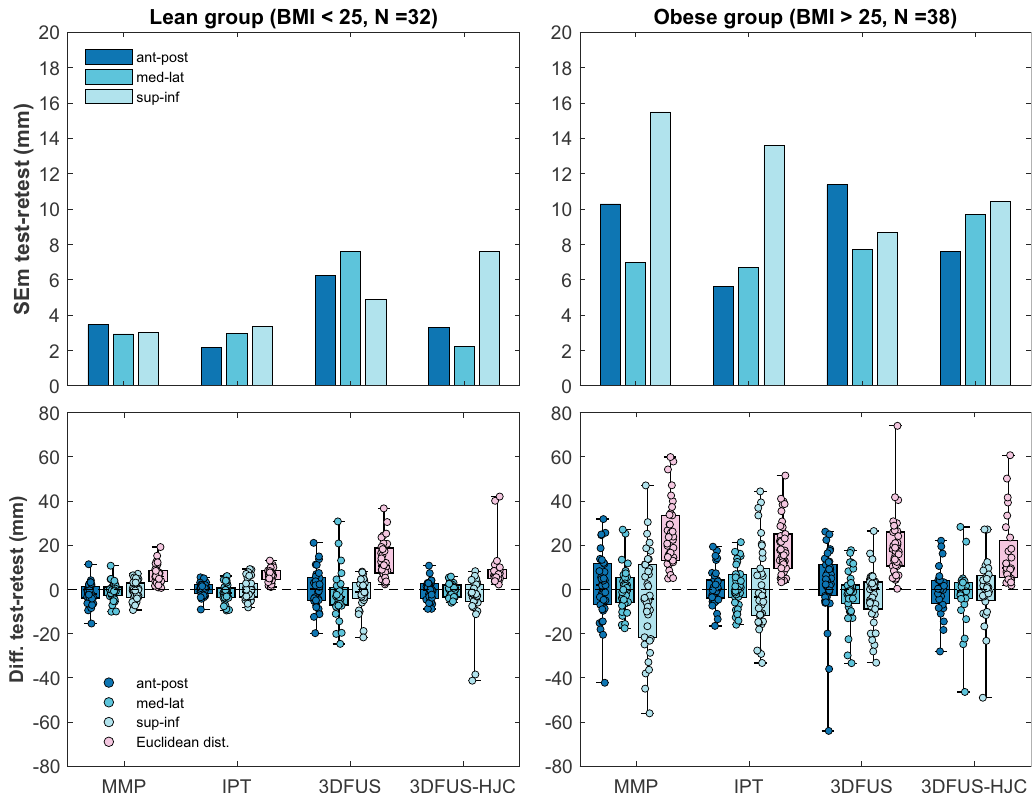
Figure 2. The upper plots show the Standard Error of Measurement (SEm) as an indicator for test–retest reliability for the anterior superior iliac spine (ASIS) location in all three anatomical planes. The lower plots show the distances between test and retest of the ASIS location in all three anatomical planes as well as the Euclidean distances between test and retest. Plots show a boxplot (with the median) and the raw data. ASIS were determined by manual marker placement (MMP), an instrumented pointer technique (IPT), and by the 3D free-hand ultrasound approach (3DFUS). The hip joint center (HJC) was localized by 3DFUS. Analyses were performed within a lean (left plots) and an obese study sample (right plots). Note that 11 trials (legs) from the obese and two trials (legs) from the lean group had to be removed for 3DFUS-HJC due to problems with image quality and a technical problem,